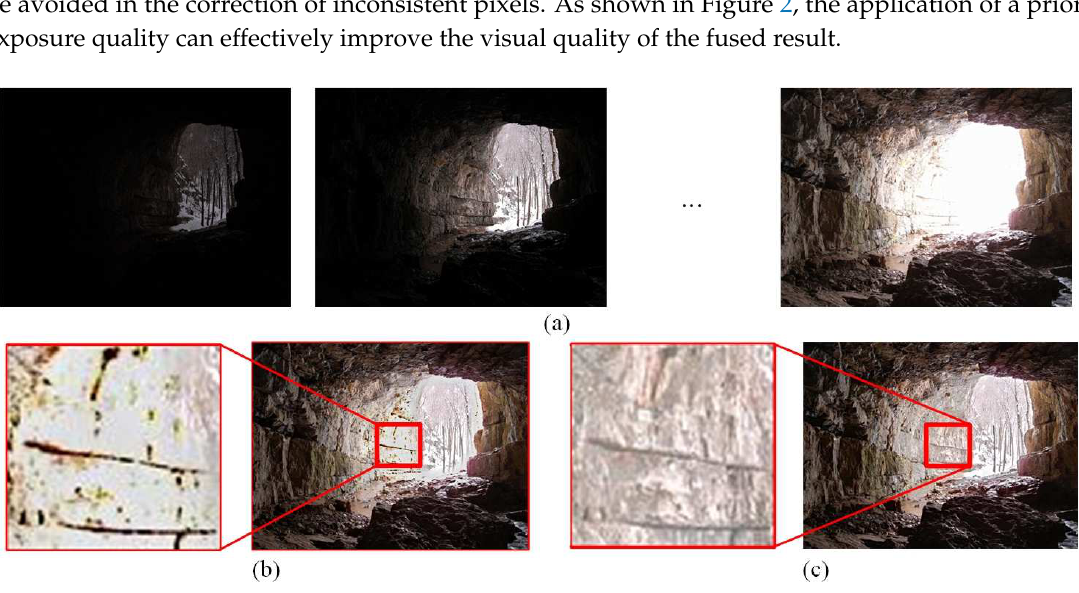
Figure 2. ( a ) Source images, ( b ) an image obtained by the reference image without a priori processing, and ( c ) an image obtained by the reference image with a priori